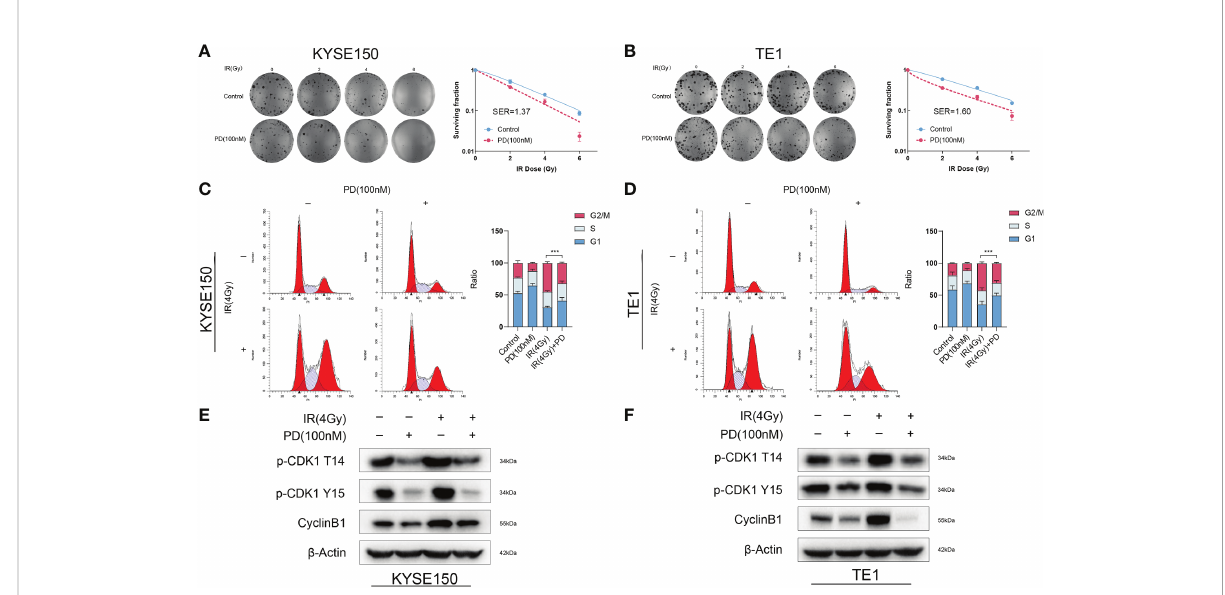
FIGURE 3 PD sensitizes ESCC cells to irradiation and disrupts the G2/M arrest due to irradiation. (A, B) Clonogenic survival assays of KYSE150 and TE1 cells with different doses of irradiation. (C, D) PD disrupts the G2/M arrest induced by irradiation, reducing the G2/M ratio of cell cycle in ESCC cells. (E, F) PD induces altered expression of G2/M phase-related cyclins. ***P < 0.001.